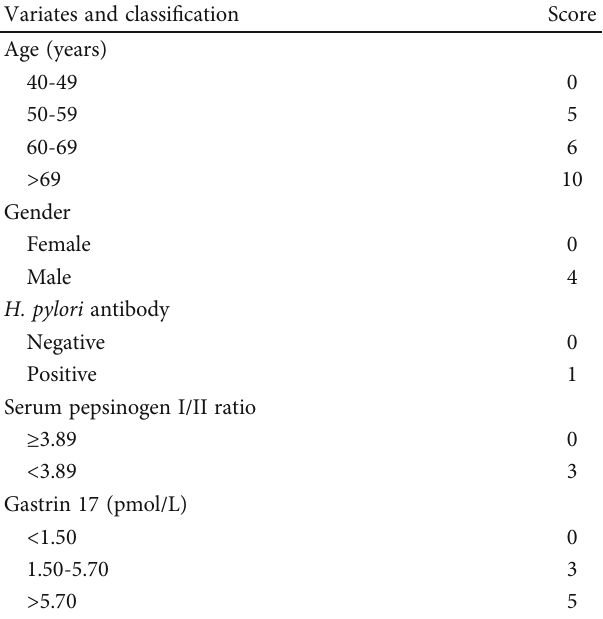
Table 1: Chinese new gastric cancer screening scoring system.